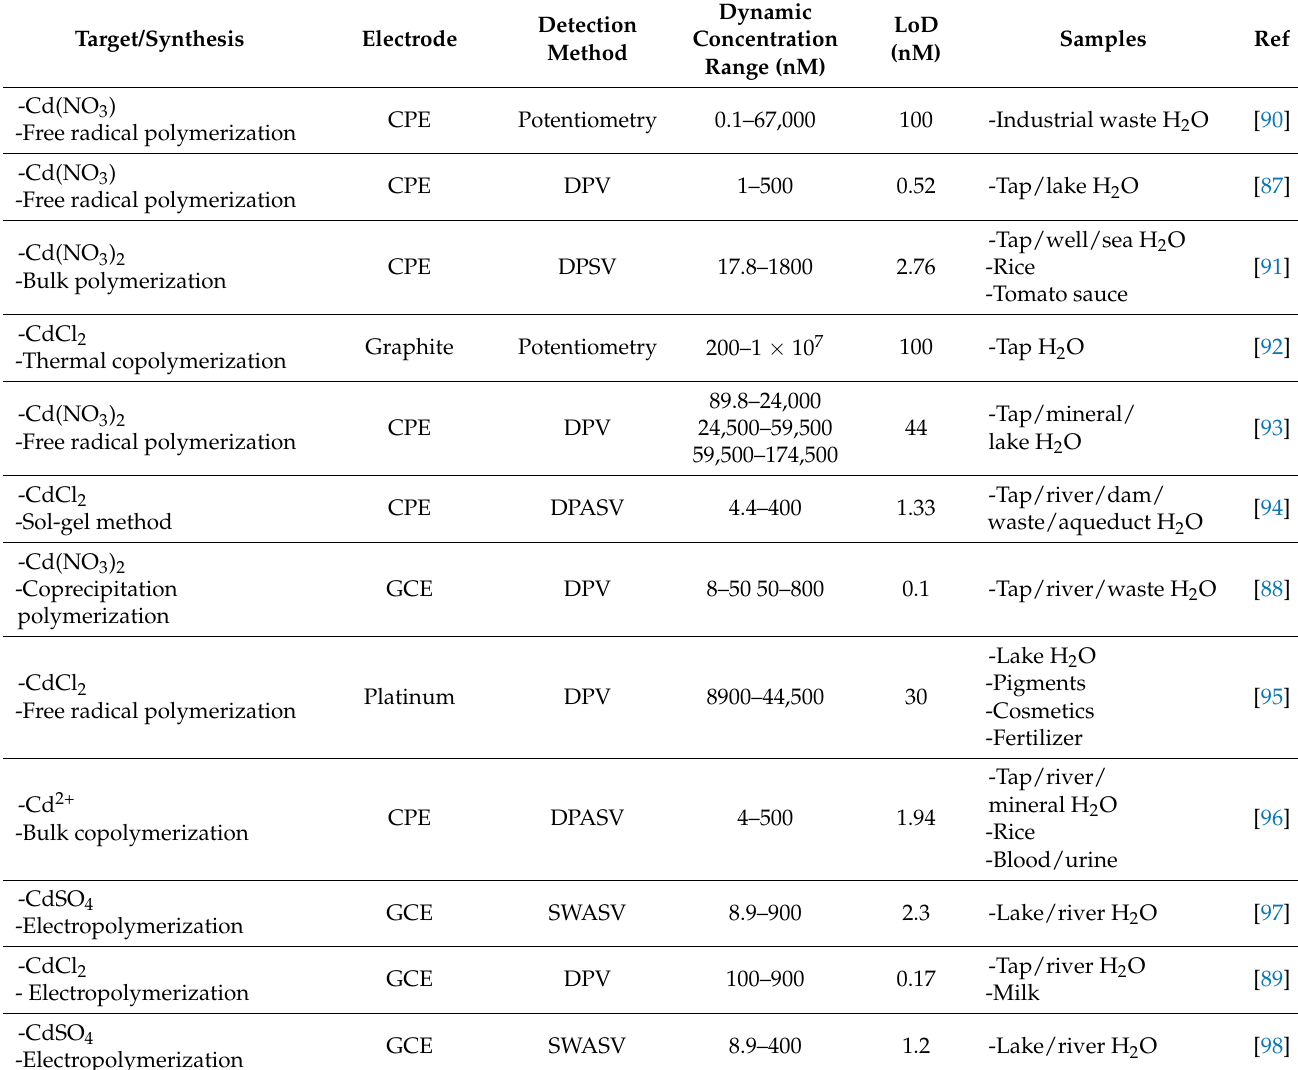
Table 4. Summary of studies which have utilized IIPs for the electrochemical detection of